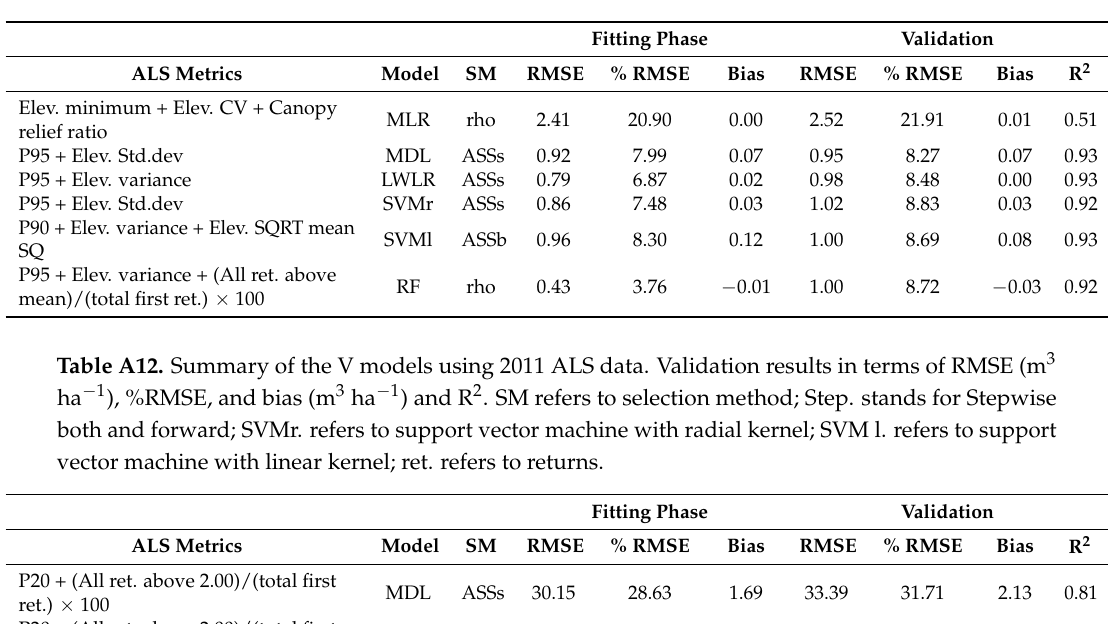
Table A11. Summary of the Ho models using 2016 ALS data. Validation results in terms of RMSE (m), %RMSE, and bias (m) and R 2 . SM refers to selection method; Step. stands for Stepwise both and forward; SVMr. refers to Support Vector Machine with radial kernel; SVM l. refers to Support Vector Machine with linear kernel; ret. refers to returns.